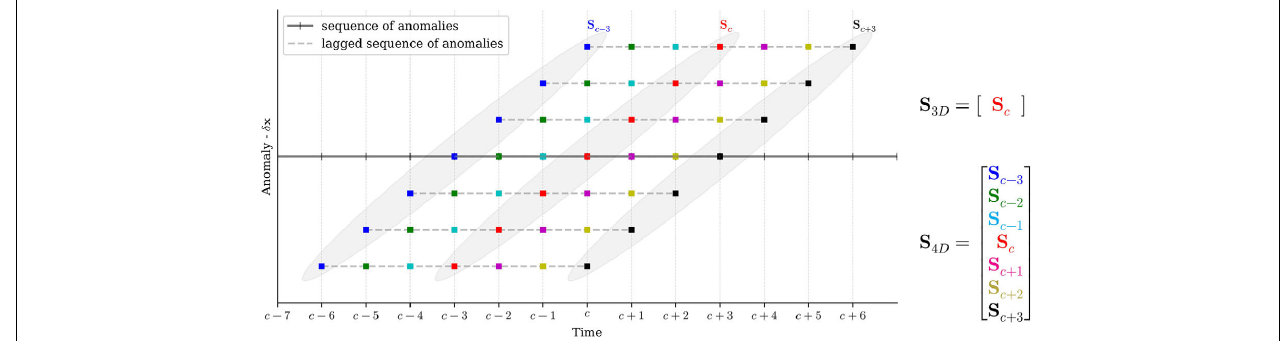
FIGURE 10 | Schematic construction of the anomaly matrix S for the 3D and 4D analysis scheme. Colours represent the days within the DAw. Shaded ellipses represent the anomaly matrices for days c- 3, c and c+ 3. “Lagged sequence of anomalies” (dotted lines) were displaced in the vertical axis with respect to the “sequence of anomalies” (full line) for visualisation purpose. The S 4 D covariance matrix corresponds to the S 3 D matrix augmented with past and future anomaly matrices. Their number of columns is the